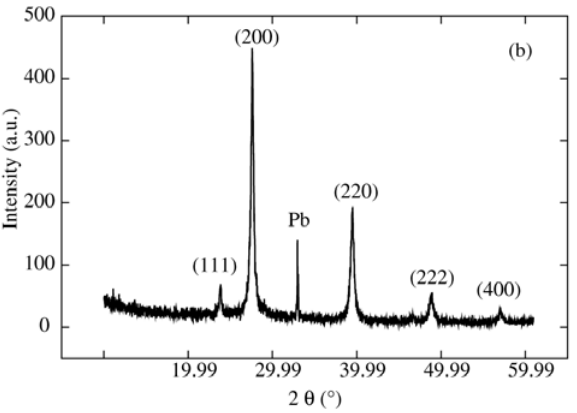
Figure 4. X-ray diffraction of PbTe thin film electrodeposited at potential of 0.98 V × Ag/AgCl by potentiostatic process on PSL etched during 3 min.